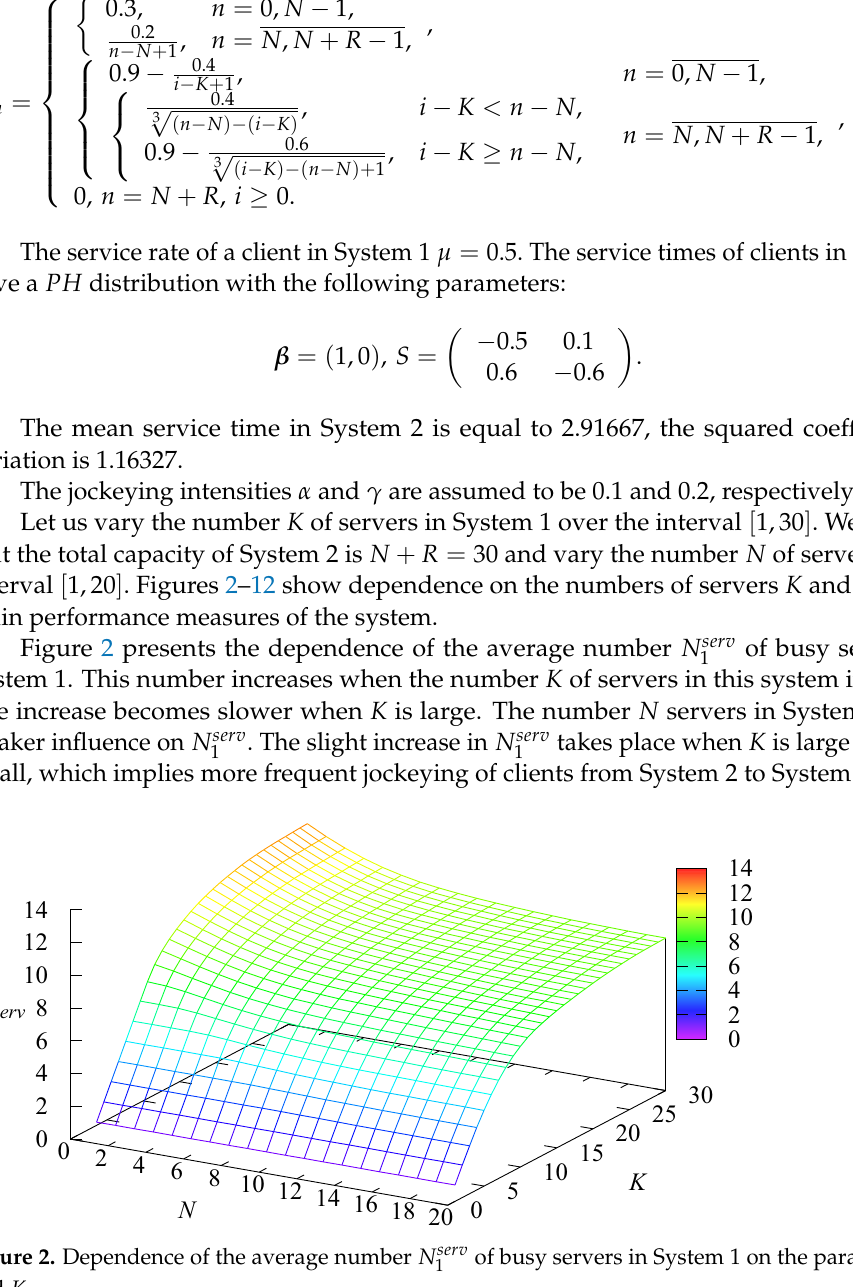
of busy servers in System 1 on the parameters N 1